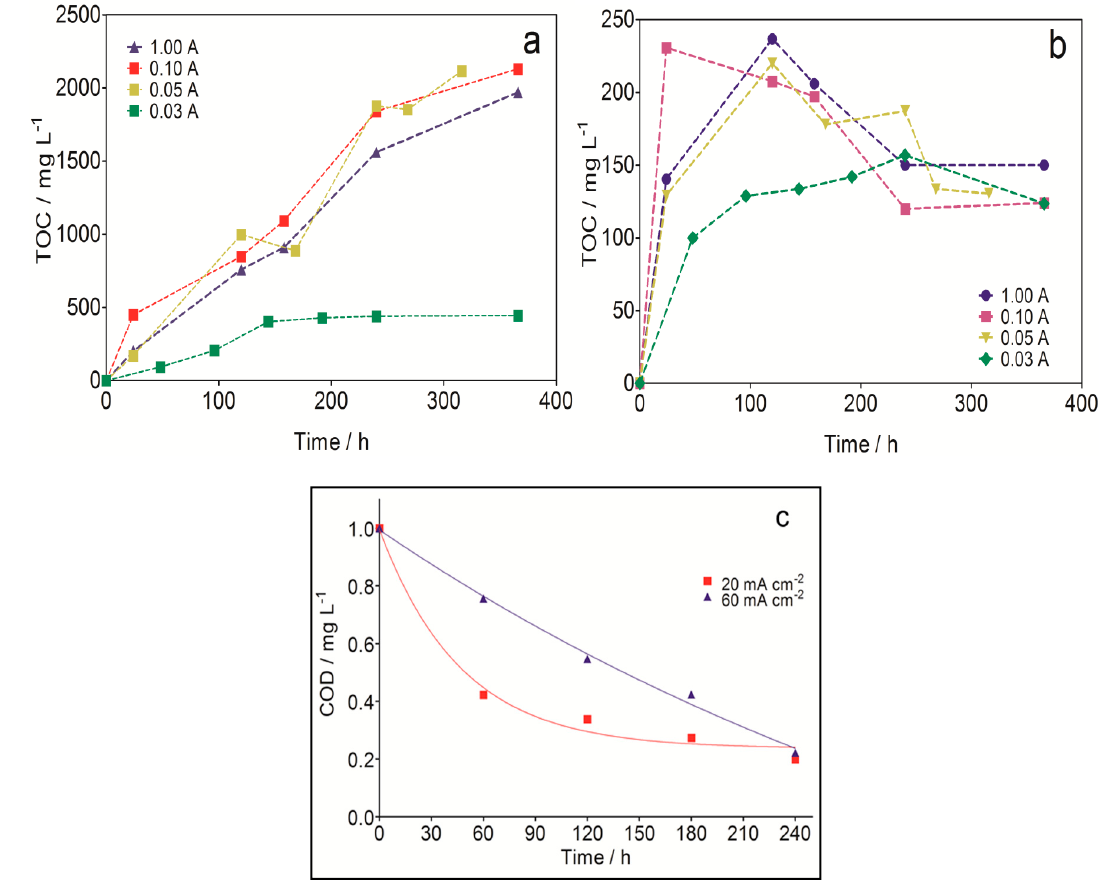
Figure 9. TOC evolution as a function of time at ( a ) anodic and ( b ) cathodic compartments during the electrokinetic soil remediation (EKSR) applying different current values at 25 °C with 0.1 M Na 2 SO 4 as supporting electrolyte by using graphite electrodes; ( c ) Decay of normalized COD with time obtained during the electrochemical treatment of effluents produced after EKSR of soil polluted with petroleum at applied current density of ( ■ ) 20 mA cm − 2 and ( ▲ ) 60 mA cm − 2 . Reprinted with the permission of [129].